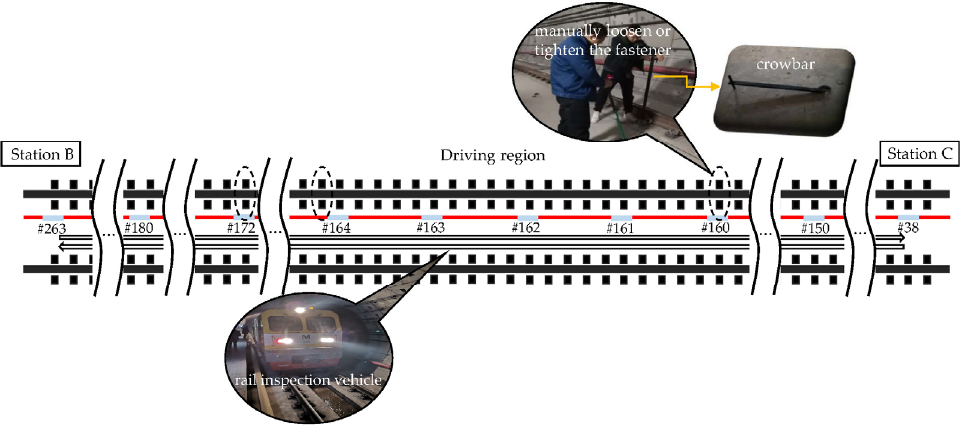
Figure 2. Position of the selected fasteners and detection area of the ultra-weak FBG sensing array.